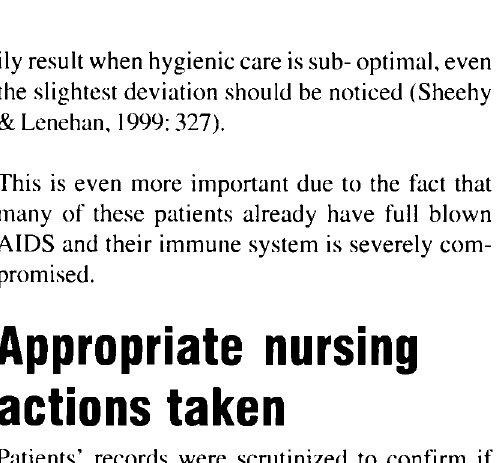
Figure 7 Outcome of hand nails & feet care as percentage of total observations (N = 30)